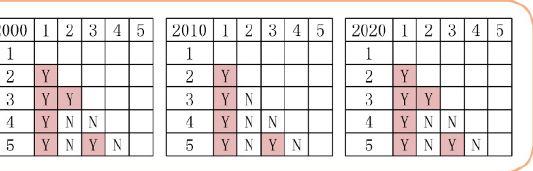
Figure 11. The risk detector results of the Integrated Human Footprint Index without the LULC factor.